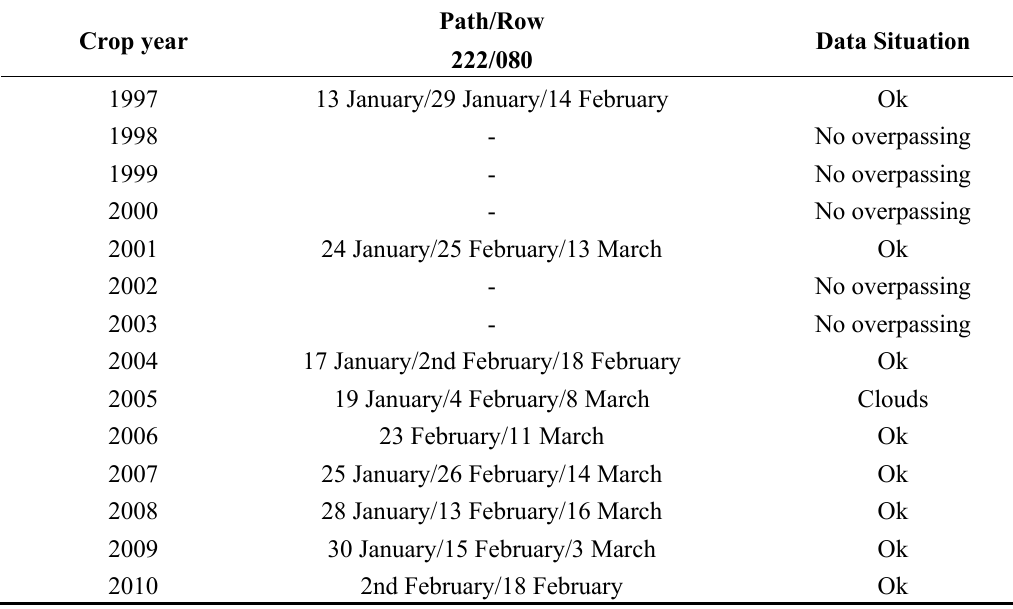
Table 1. Selected Landsat-5 TM images for soybean crop area